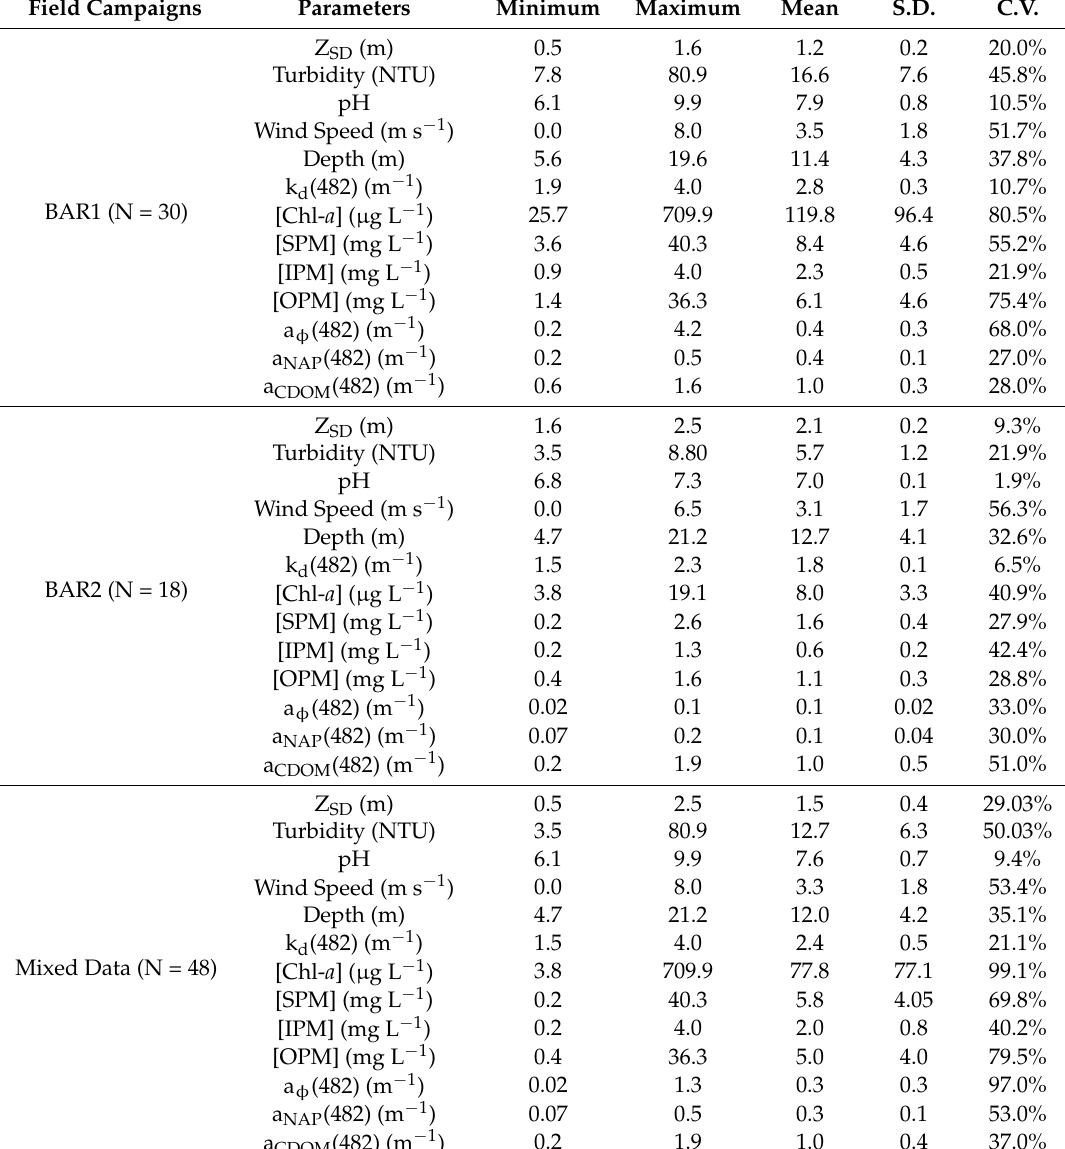
Table 2. Descriptive statistics for optical and water quality parameters for BAR1, BAR2, and the mixed data. Field Campaigns Parameters